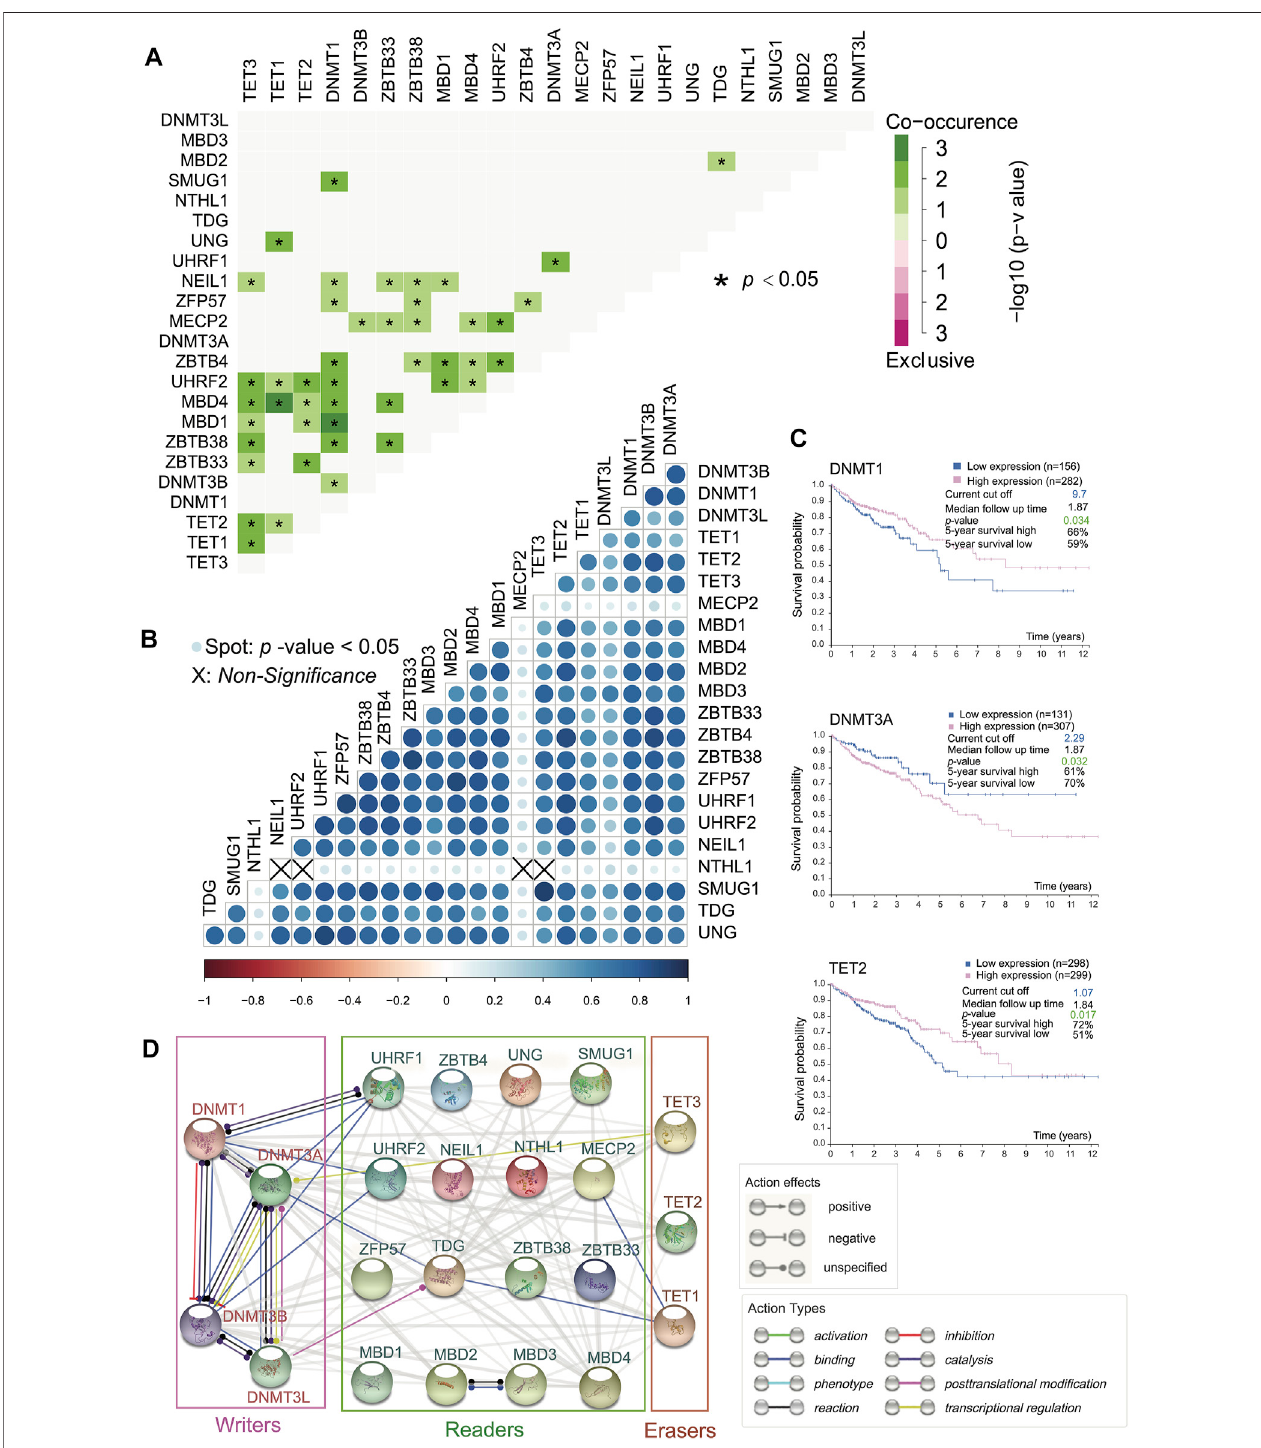
FIGURE 2 | Positive interaction generally among 5mC regulators and survival analysis. (A) Somatic mutation interactions among 23 5mC regulators. (* p -value < 0.05).DNMT3LandMBD3arenotrelatedtoother5mCregulators.Othersigni fi cantrelationshipsarepositive. (B) SCCregardingexpressionpro fi leof235mCregulators (Spot: p -value < 0.05). Writers are related toerasers and readers. (C) Overall survival curves ofDNMT3A, DNMT1, and TET2 ( p -value < 0.05) indicate that all ofthem are clinically signi fi cant. (D) Functional protein association network among 5mC regulators.